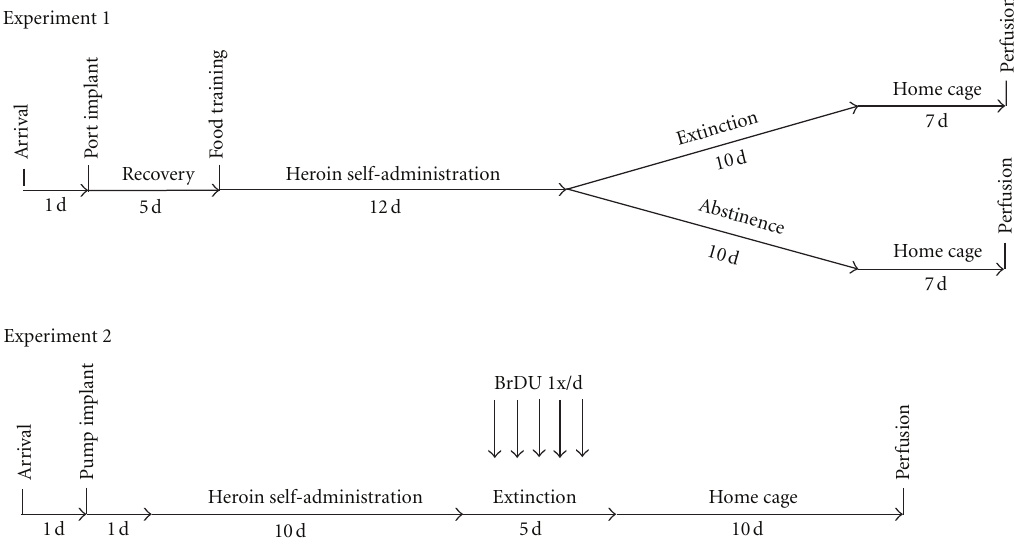
Figure 1: Timelines of procedures in Experiments 1 and